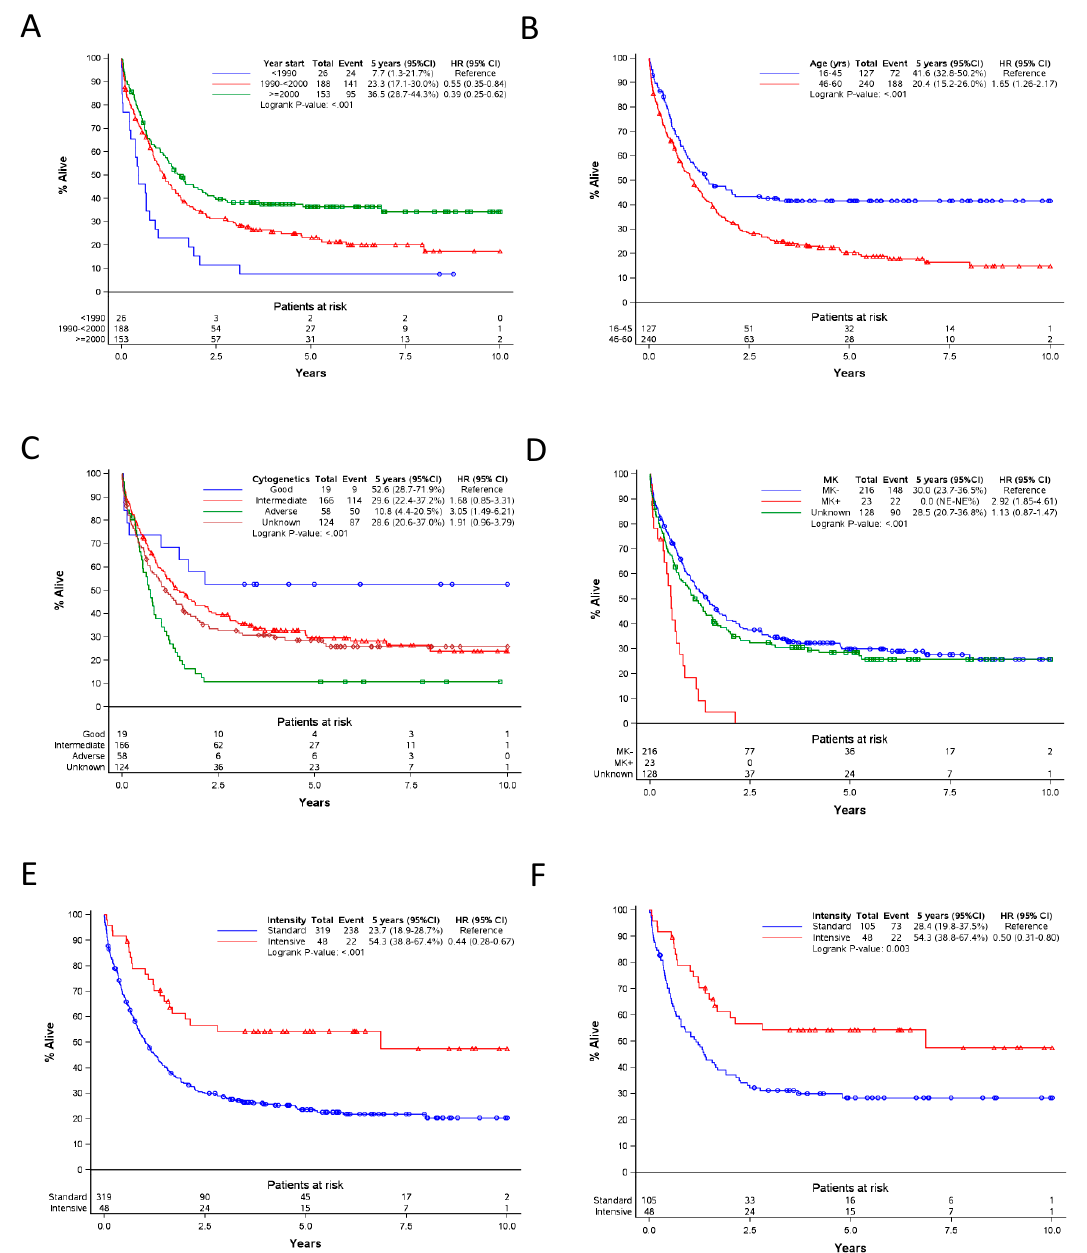
Figure 1. ( A , B ), in younger patients (age ≤ 60 years): association between treatment period ( A ), initial features ( B – D ), treatment intensity (high dose versus standard dose AraC) (( E , F ) restricted to patients treated ≥ 2000) and OS.